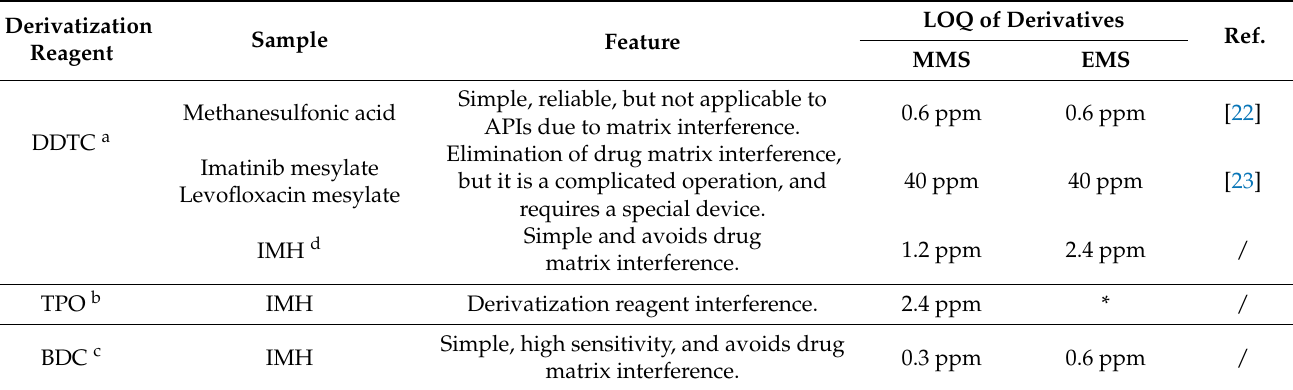
Table 1. A comparison of the derivatization